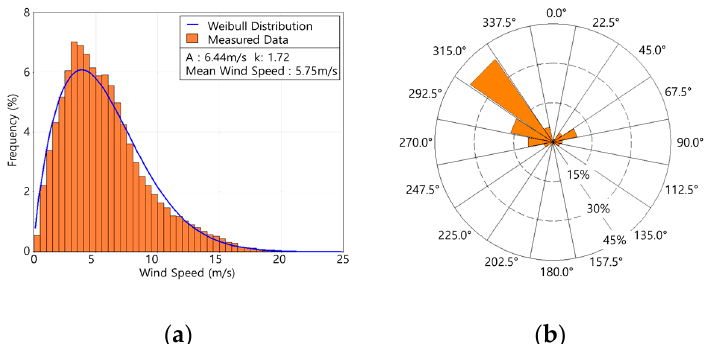
Figure 3. Measured wind data for the target wind turbine: ( a ) Weibull distribution; ( b ) total wind energy rose.